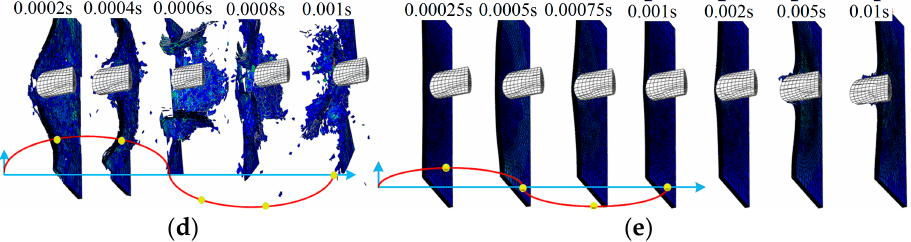
Figure 12. The middle section of the half model during the impact: ( a ) group B1; ( b ) group B3; ( c ) group B5; ( d ) group B7; ( e ) group B4.